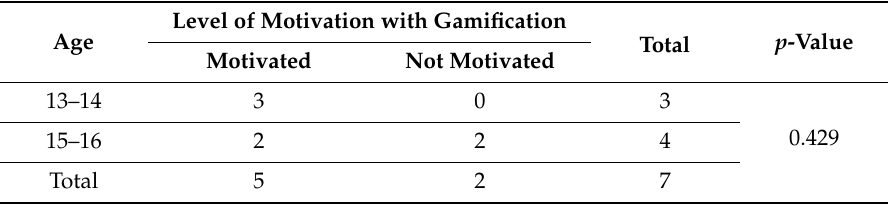
Table 7. Level of motivation with gamification by